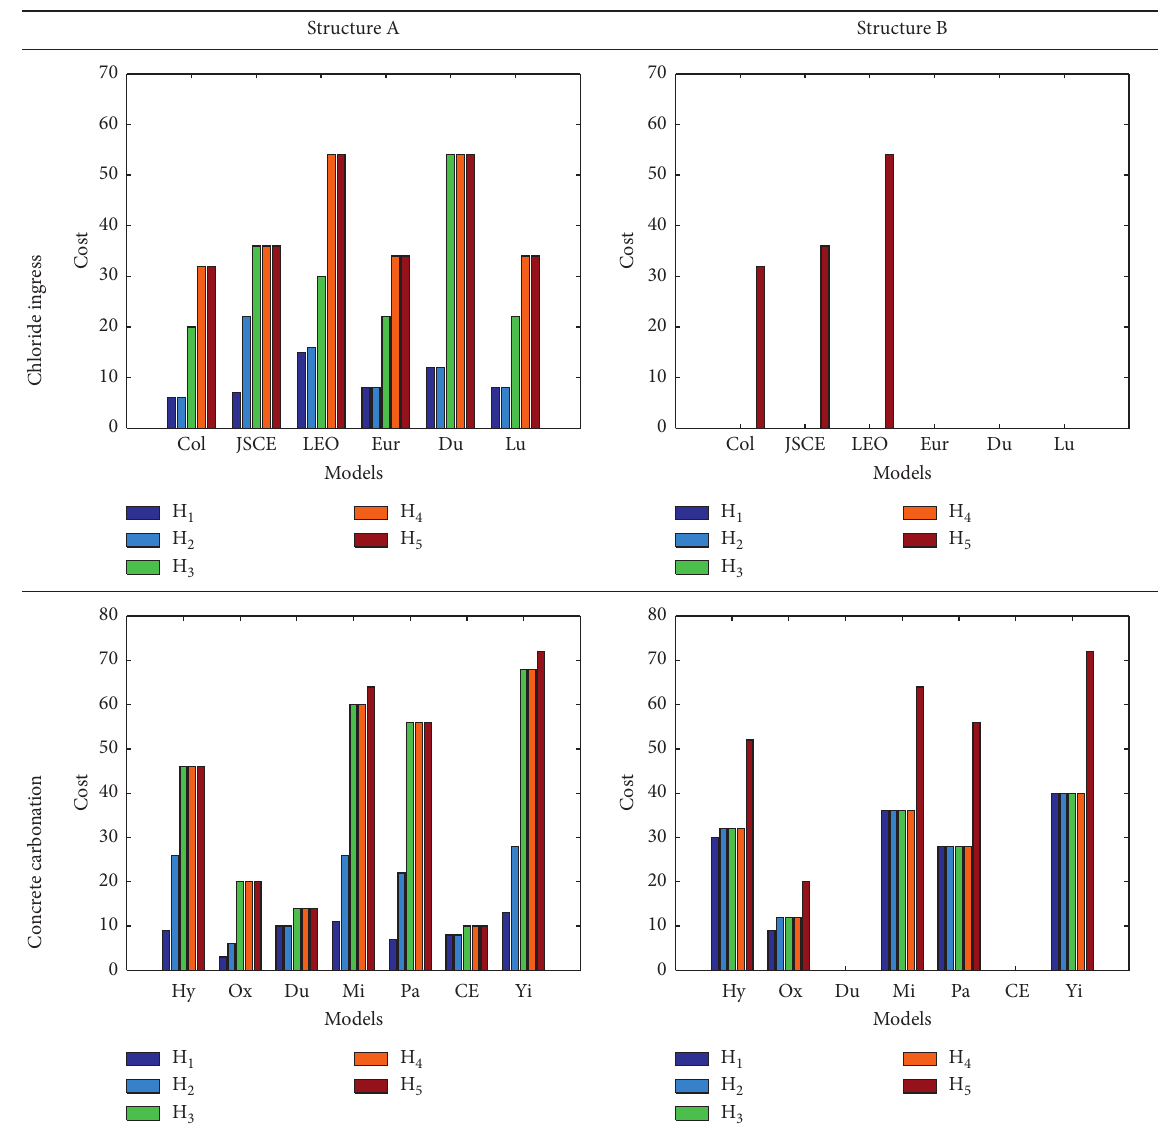
Figure 3: Cost of each model according to each hypothesis for structure A and structure